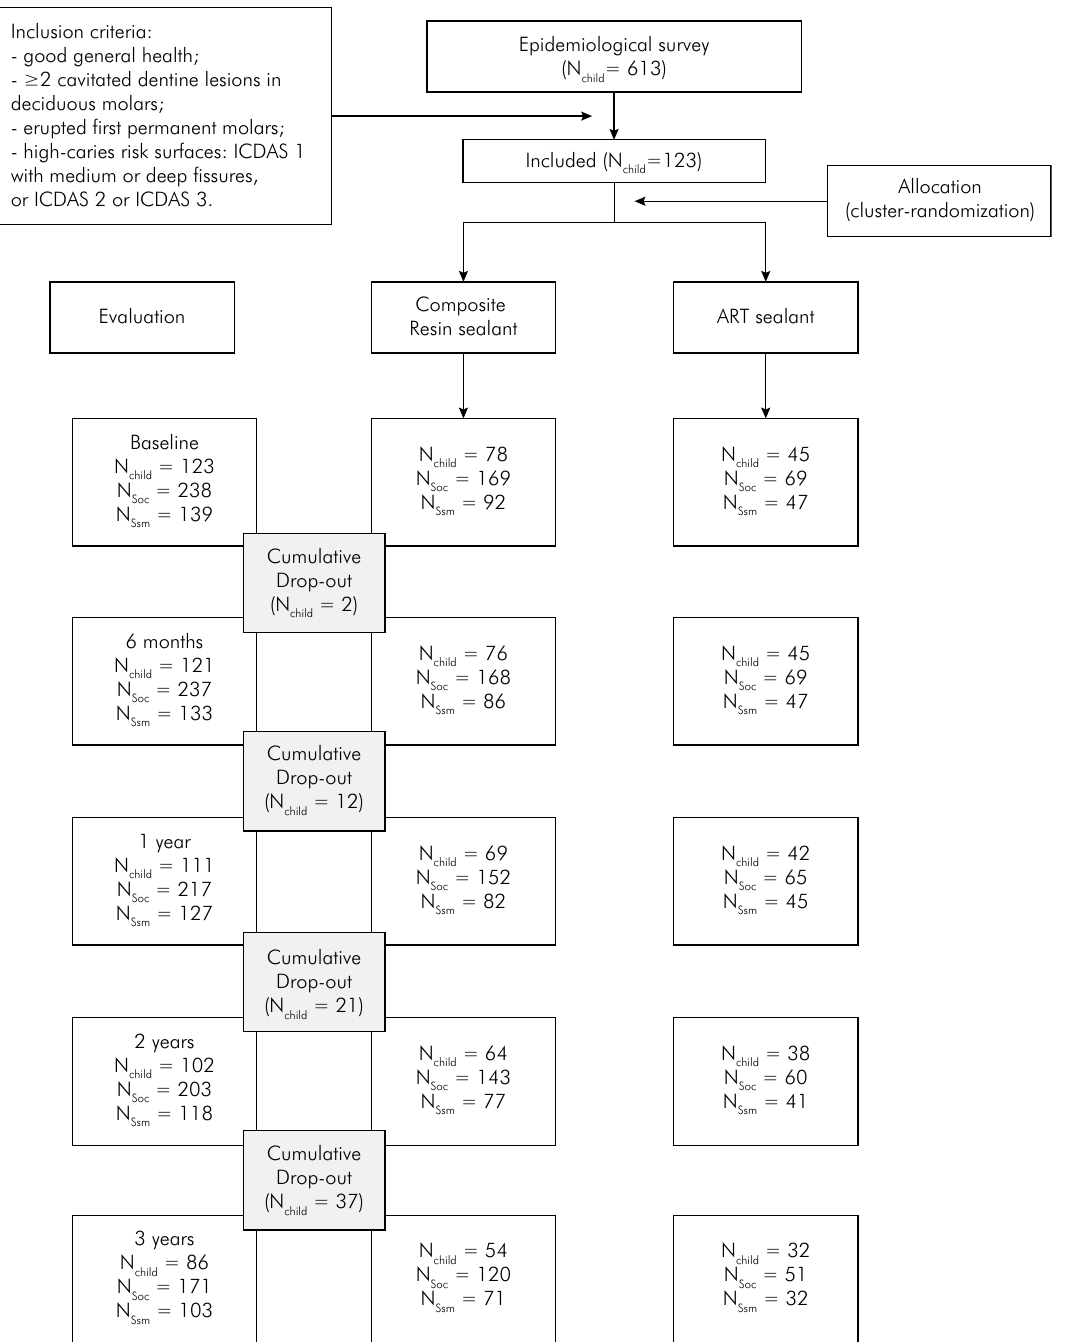
Figure 1. Consort flowchart. (Nchild=Number of children; NSoc: number of occlusal surfaces; NSsm: number of smooth surfaces; ART: atraumatic restorative treatment). Reasons for dropouts were: moving to another city and irregular school attendance.